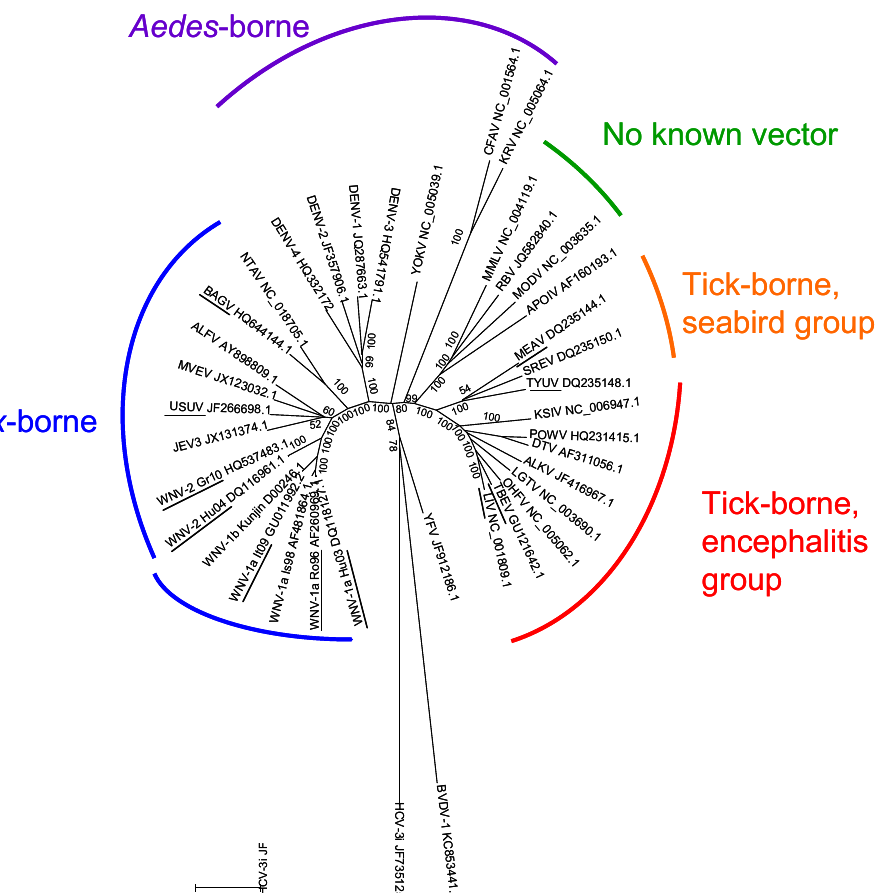
Figure 1. Genetic relatedness of flaviviruses, evaluated using genetic alignments of complete genomic sequences. GenBank accession numbers are indicated on the tree branches of each